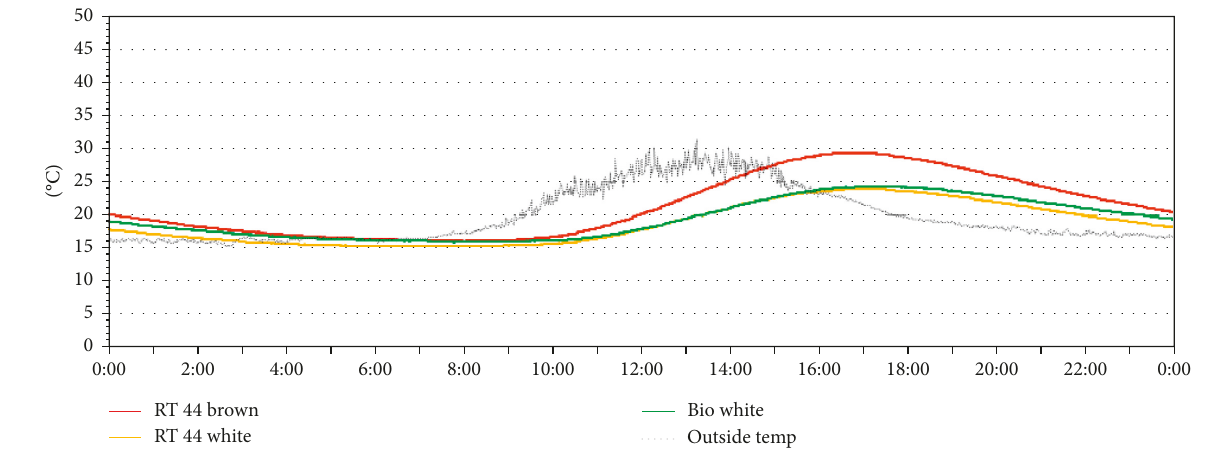
Figure 13: Ceiling temperature graph of Test